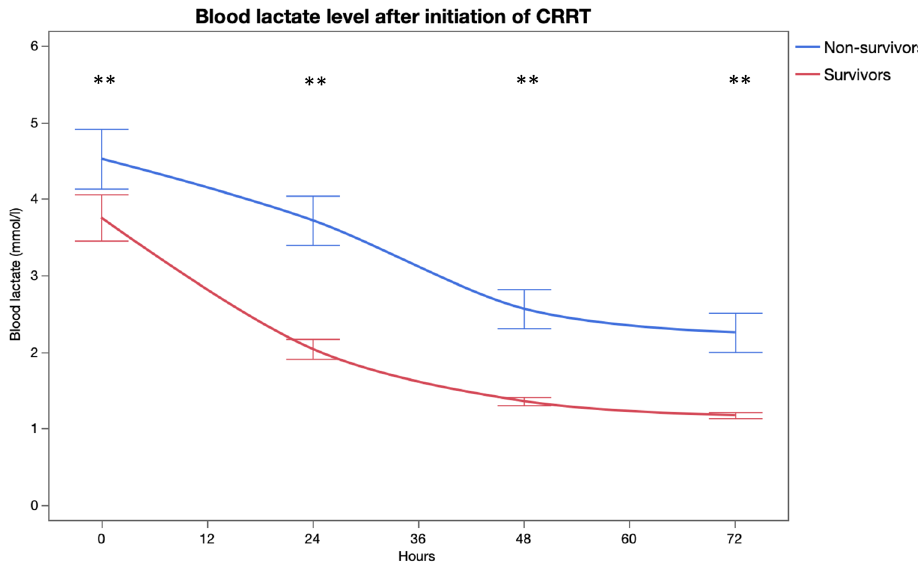
Figure 3. Lactate by time (*p < 0.01, **p < 0.001). The figure was generated using JMP Pro 15.1.0 software. Copyright 2019 © SAS Institute Inc. JMP Pro and all other SAS Institute Inc. product or service names are registered trademarks or trademarks of SAS Institute Inc., Cary, NC, USA.